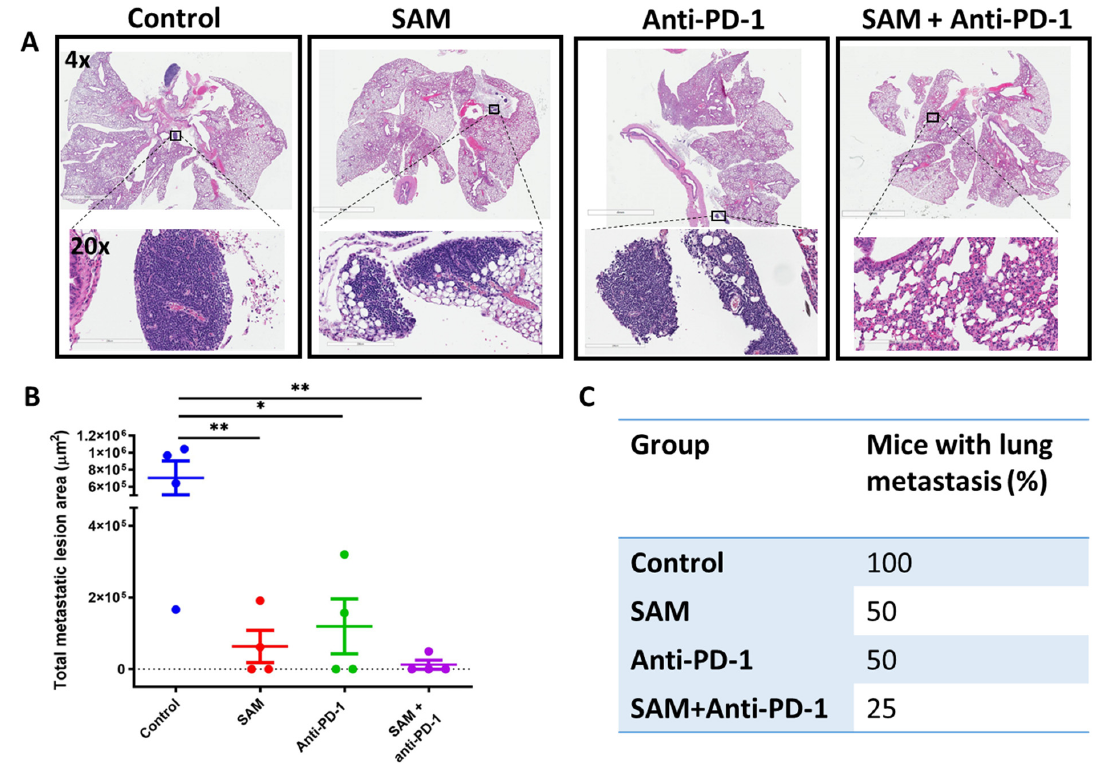
Figure 4. SAM, anti-PD-1 antibody, and the combination treatment decreased lung metastasis in Eo771 tumor-bearing mice. Briefly, mice were injected with Eo771 cells orthotopically at the m.f.p and treated with the four treatments indicated. At the end of the study, lungs of the mice were harvested, fixed using formalin, embedded in paraffin, sliced, and stained with H&E. ( A ) Representative histology images of mouse lung showing the whole lung and magnified images to show metastatic lesions from each group except the SAM+anti-PD-1 antibody combination group, which had no lesions in this sample. Lens: top; 4 × ; bottom; 20 × . Magnification: top; 40 × ; bottom; 200 × . ( B ) Total metastatic lesion area ( µ m 2 ± SEM) for each group ( n = 4/group). Total metastatic lesion area was calculated